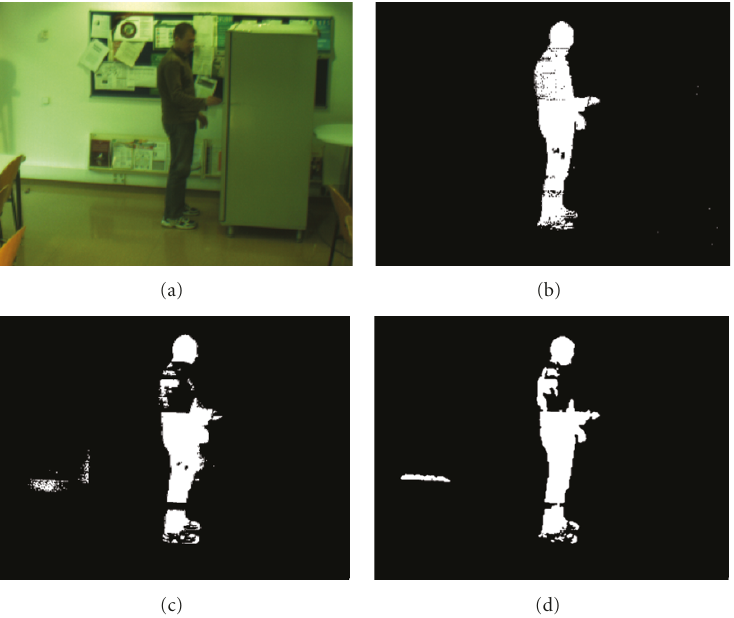
Figure 3: (a) Original image, segmentation result of (b) our method, (c) Stau ff er method, and (d) K. Kim